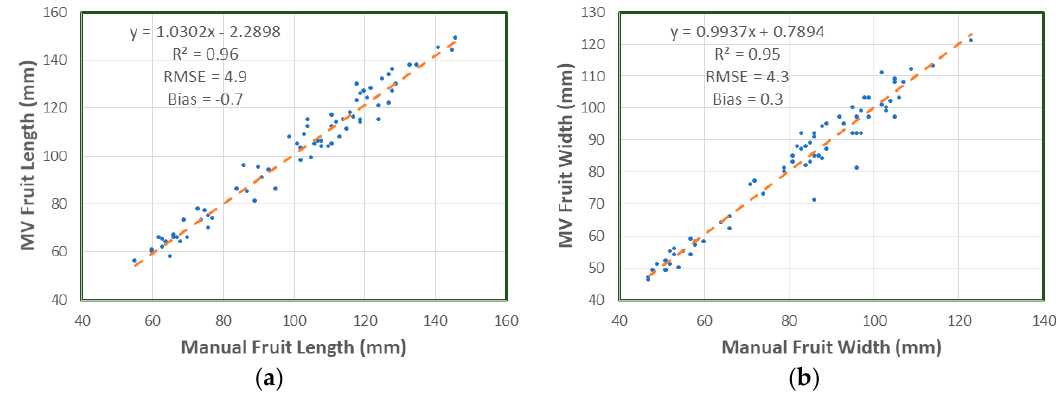
Figure 5. Machine vision (MV) and manual caliper measurement of: ( a ) length; ( b ) width of mango fruit on tree for the validation set images.